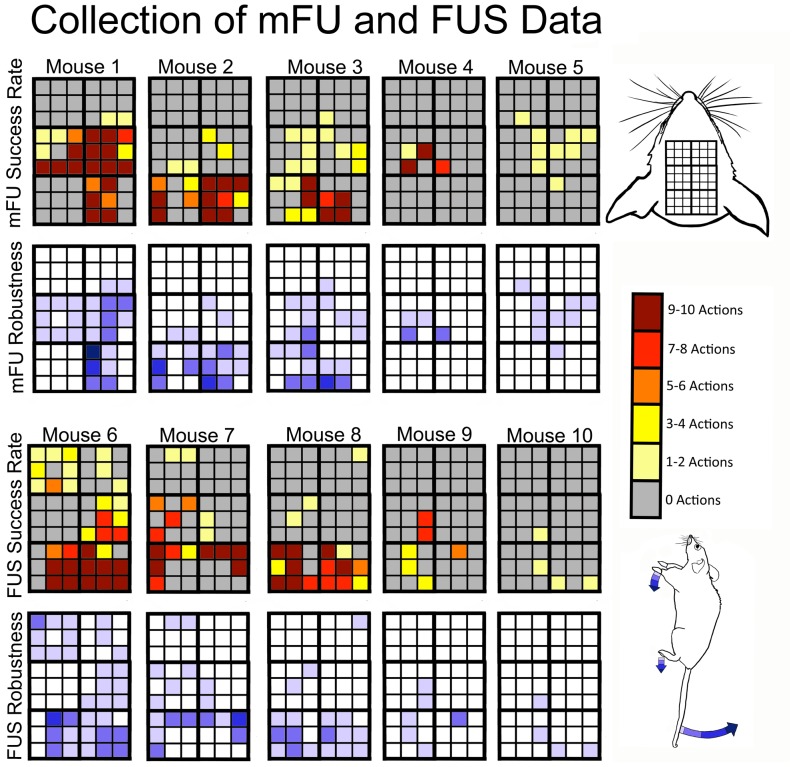
Motor stimulation data for all ten mFU and ten FUS mice.The red-shaded colors denote number of actions with a maximum value of ten while the range of blue shades quantifies the size of motion. The top two rows show results due to mFU alone while the bottom two rows show results due to FU alone. Results are displayed with the highest success rate to the left and lowest success rate to the right.